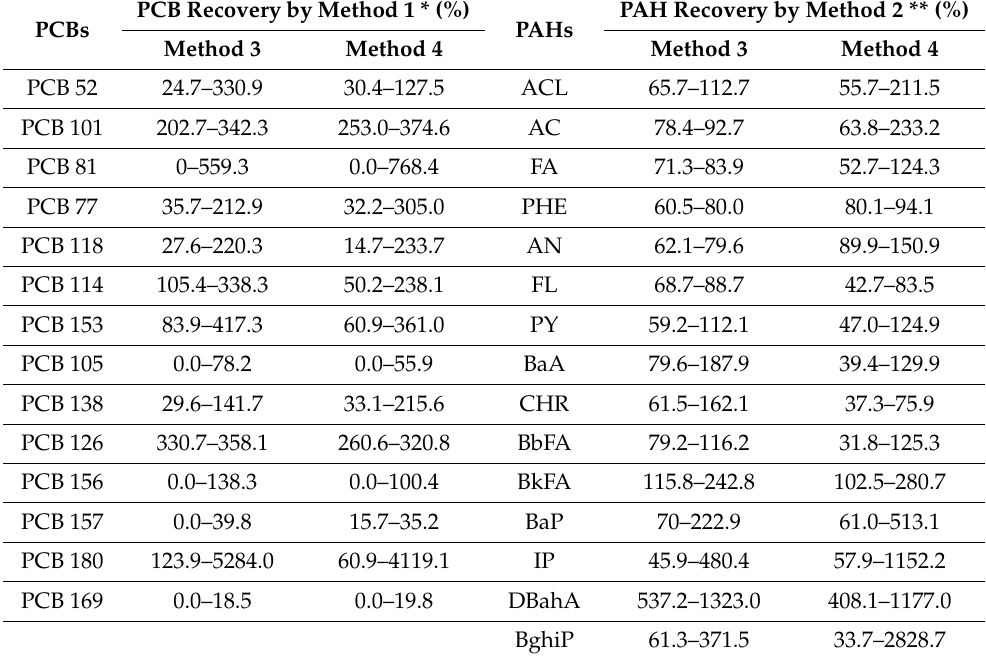
Table 4. Value ranges of PCB and PAH determinations in the fruits tested with methods 3 and 4 in comparison to method 1 (expressed in